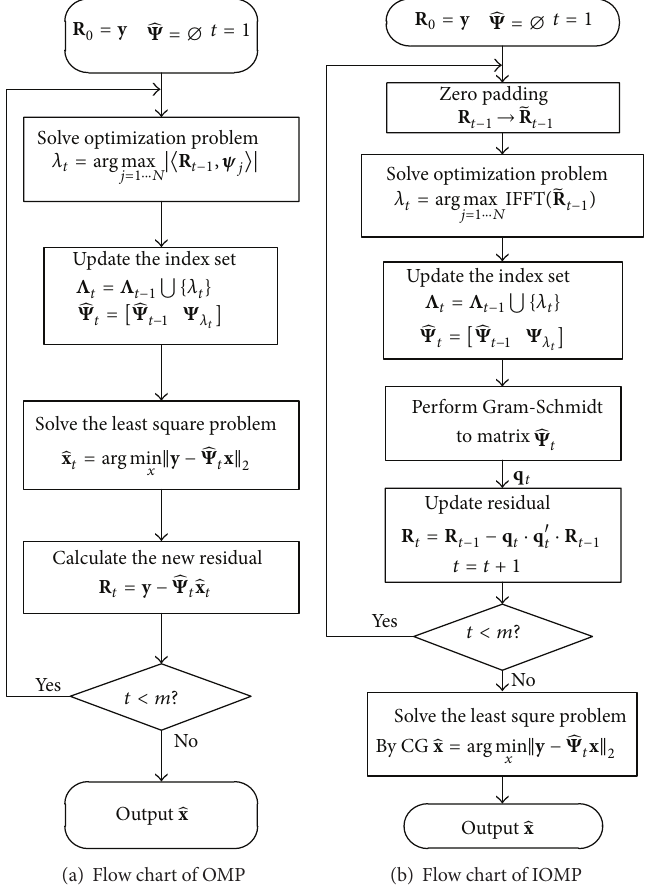
Figure 1: Flow chart of OMP and IOMP